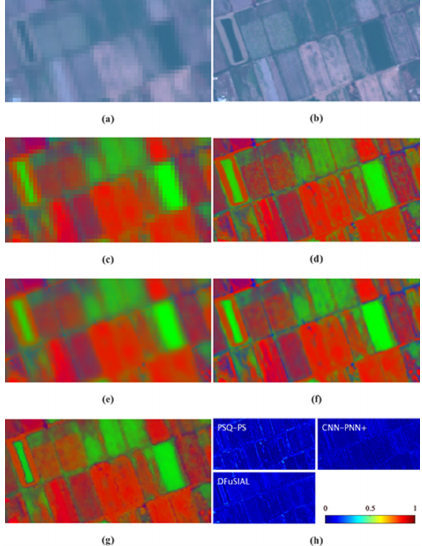
Figure 16. Zoon-in on the abundance fraction maps for three dominant EMs in the selected area for Test 5. ( a ) and ( b ) present RGB composites of the GeoEye-1 in reduced and original SR of 7.36 m and 1.84 m, respectively. ( c ) and ( d ) present corresponding fraction maps as obtained using the spectral images with LSR 7.36 m and HSR 1.84 m (used as GT), respectively. ( e ), ( f ) and ( g ) present corresponding fraction maps with HSR 1.84 m, as obtained using the images retrieved by the PSQ-PS and CNN-PNN+ methods, and as obtained by the proposed fusion method DFuSIAL, respectively. ( h ) present the corresponding area in the MAE maps of the fractions obtained by the examined methods.